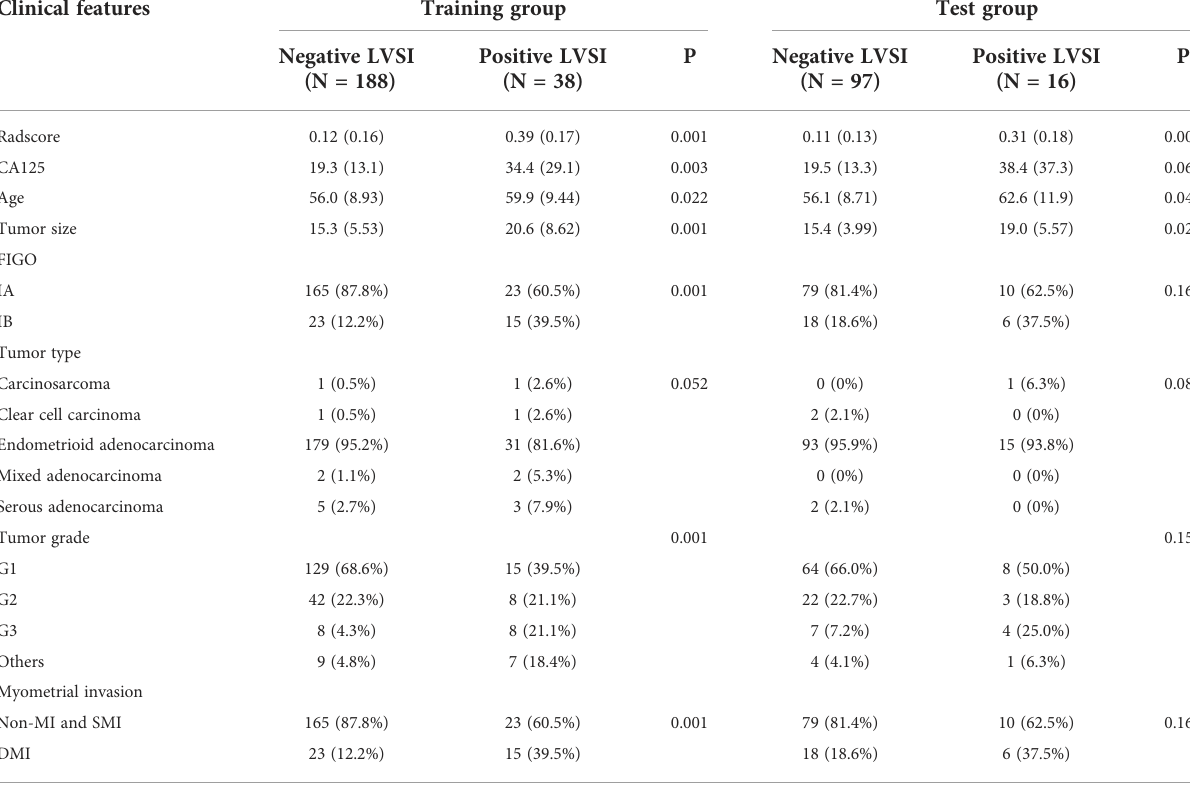
TABLE 1 The comparisons of clinicopathologic characteristics between negative and positive LVSI patients in the training and test groups. Clinical